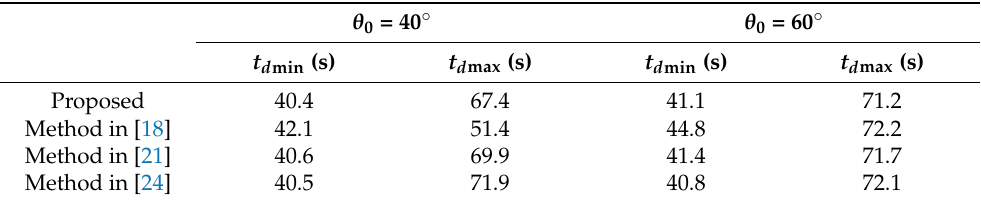
Table 1. Allowable impact time range under the four ITCG laws.